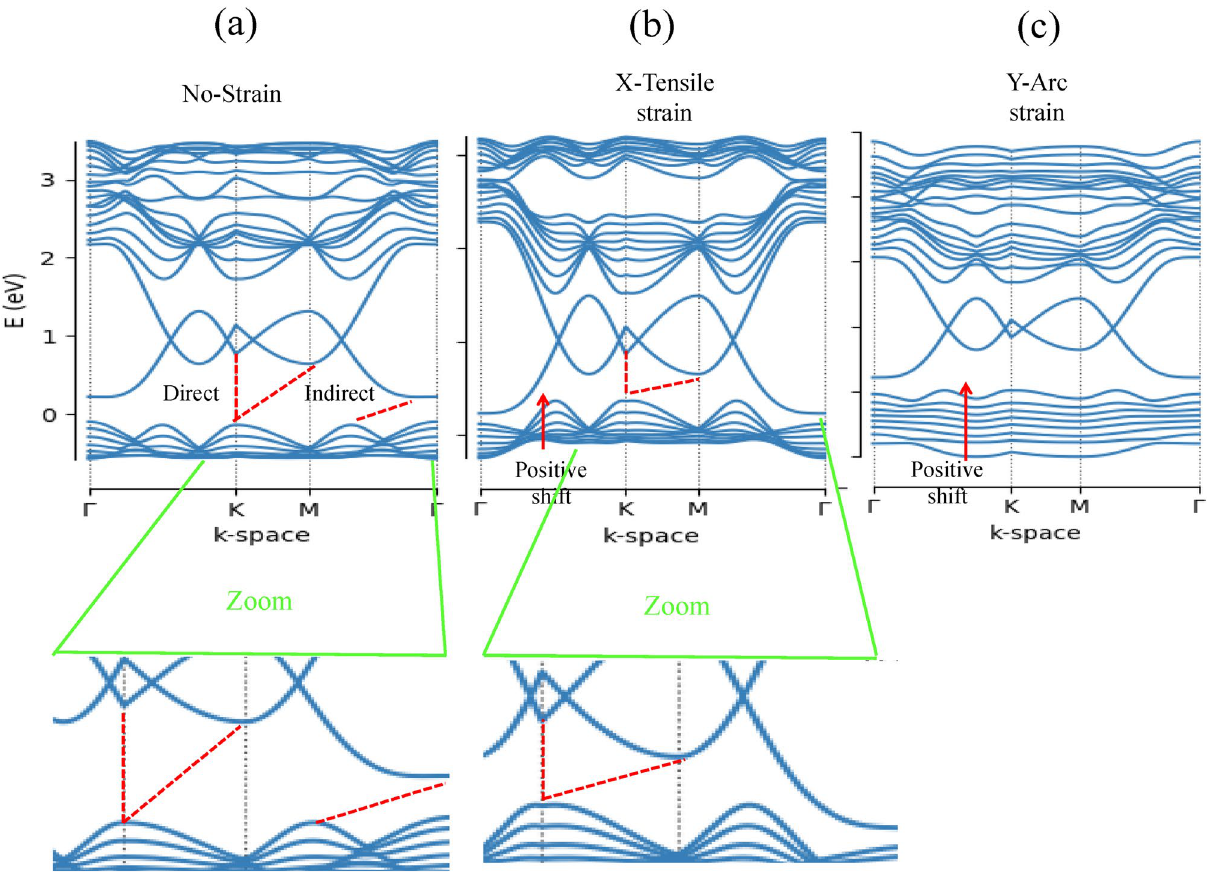
Figure 4. Electronic band structure of MoS 2 ( a ) without strain and ( b ), ( c ) with two types of strain labeled as uniaxial X-tensile and Y-arc strain. Red dashed lines show the direct and indirect band gap, while red arrows represent shifted valance valleys towards positive energies after external stimuli. Bottom panels are zoom of exterma of valance and conduction